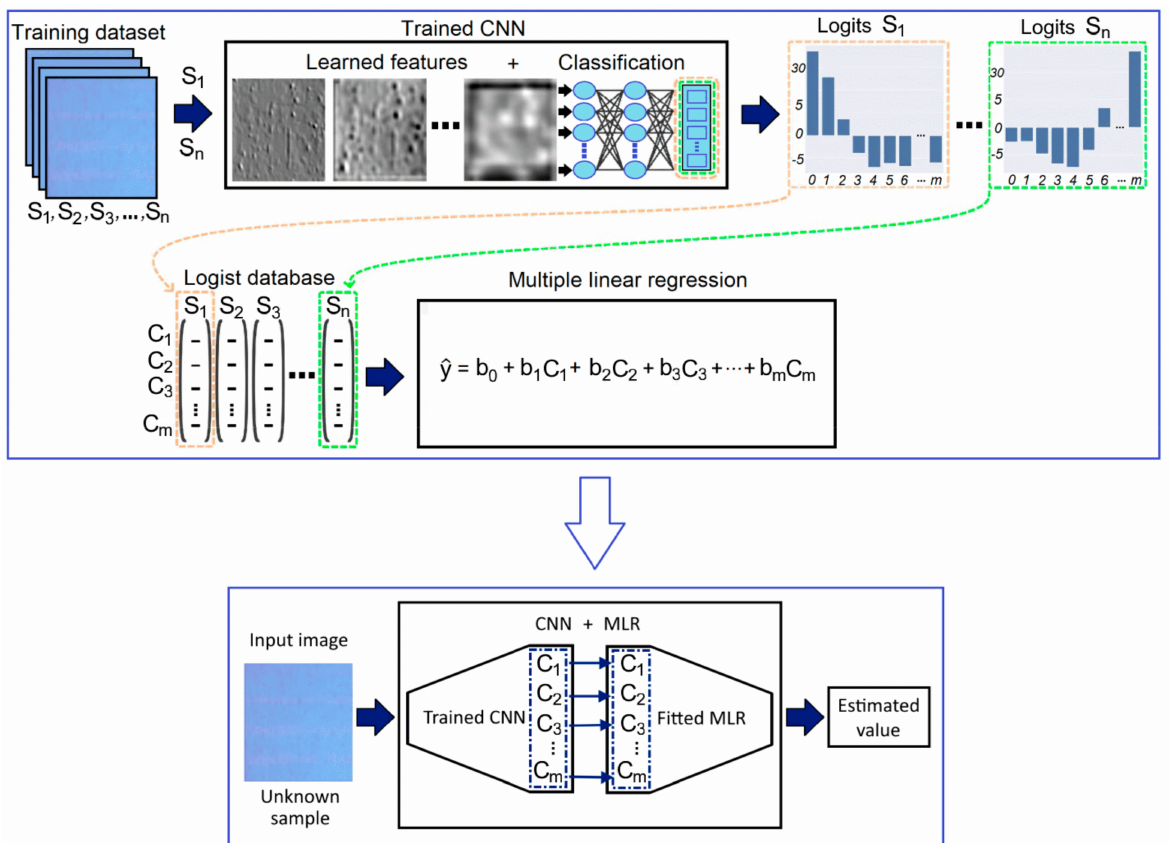
Figure 3. Extraction of logit vectors used to fit the MLR and the complete measurement system.